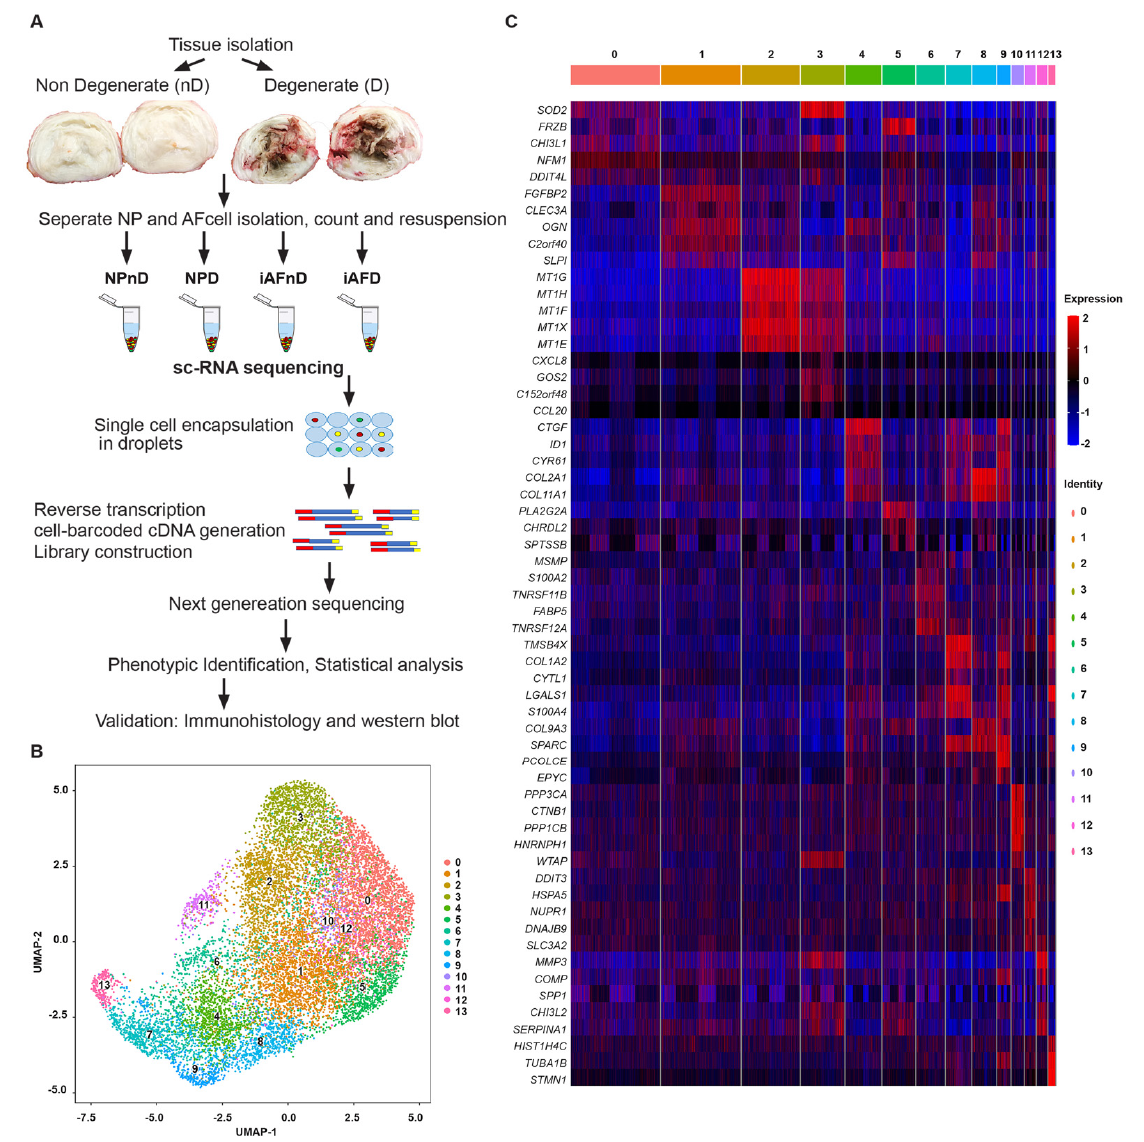
Figure 1. Single-cell RNA sequencing reveals heterogeneity of the human disc cells. ( A ) Schematic overview of the workflow of isolating and analyzing iAF and NP cells from human non-degenerating (nD) and degenerating (D) discs. ( B ) UMAP plot showing the unbiased classification of 3.131 iAFnD, 3.867 NPnD, 3.092 iAFD and 3.646 NPD. Cells are clustered according to transcriptome similarity in 2D space. Each dot represents one cell, colored by cluster. UMAP plot revealed that cells in the human disc are present in 14 unique clusters (0–13). ( C ) Heat map showing the top marker genes of each cluster (0–13) as determined by Seurat analysis. Expression of genes is represented using a z-score value in which red indicates higher expression and blue indicates lower expression.